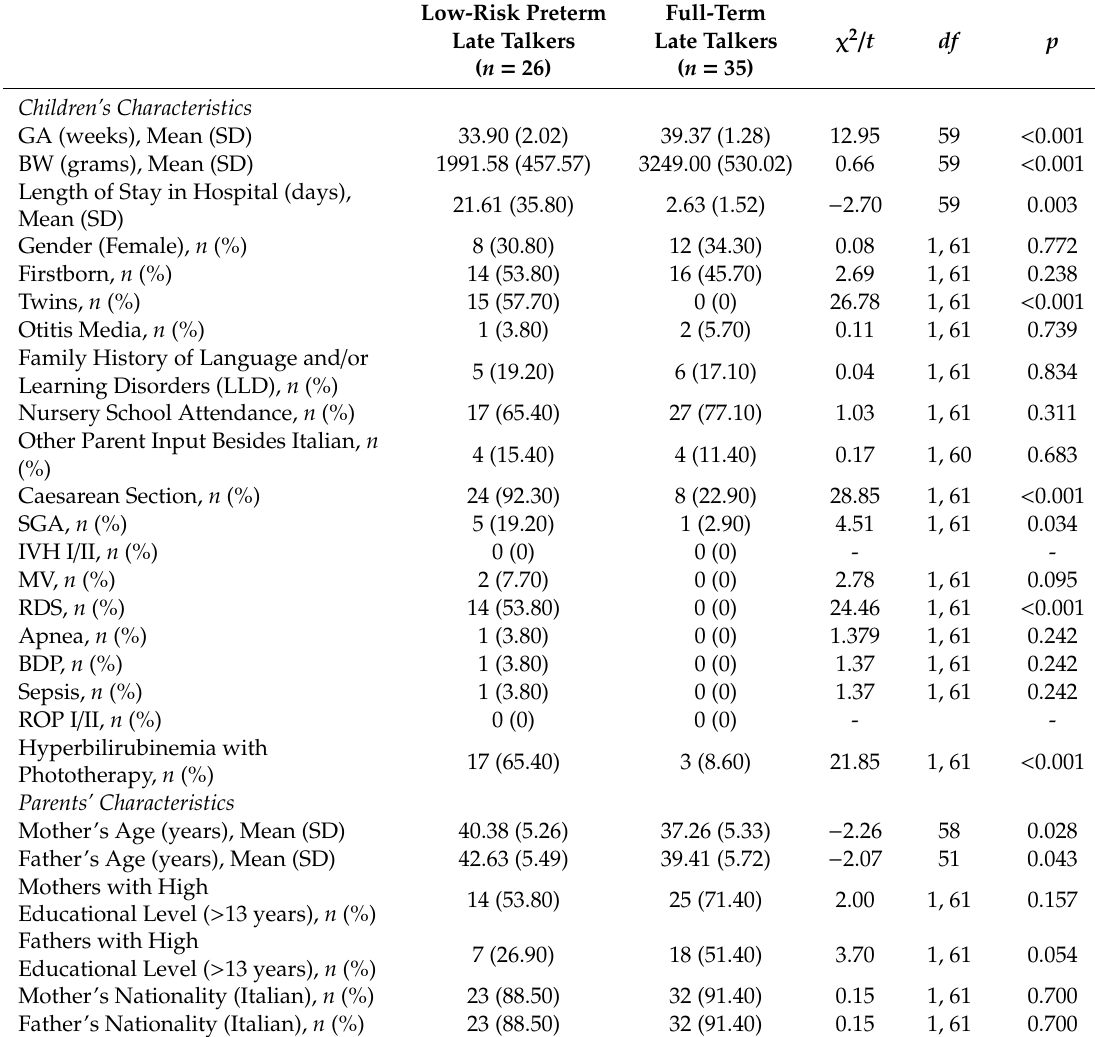
Table 1. Biological, medical and socio-demographic characteristics of the low-risk preterm and full-term late talkers and their parents and results of group